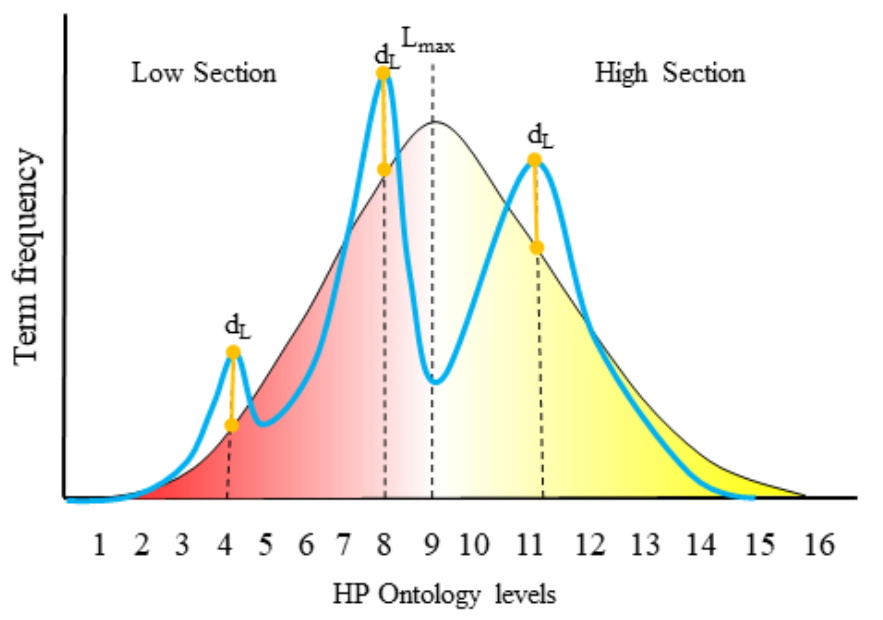
Figure 1. Term level distribution for the HPO (black line) and for a hypothetical patient cohort (blue line). The levels in the ontology are divided in two sections, the Low section and the High section . The reason for the division is based on the probability of a level being used, which is related to the number of levels that separate it from the root node in the ontology, and the number of terms contained at the level. L max is the level with largest number of terms in the ontology and it is the last level for which deeper phenotyping leads to a greater number of possible terms. The following levels have decreasing term counts, thus they have smaller probabilities to appear in a patient profile. By dividing the ontology into sections, we can see how a real patient cohort uses the ontology by measuring the distribution differences at each level ( d L ). These differences are weighted taking into account the sections and how many terms belong to each level, and are used to calculate the DsI to measure the phenotype information of a patient